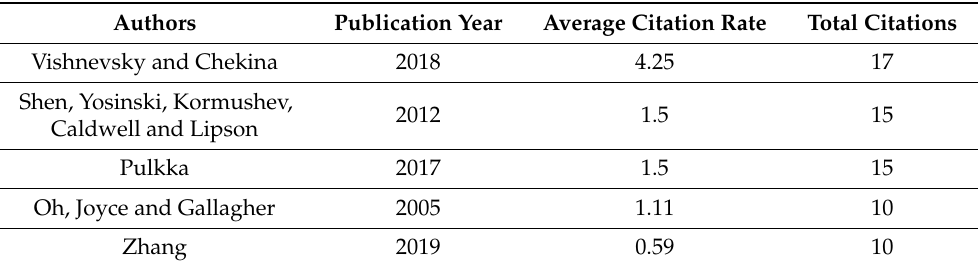
Table 3. The ranking of the most cited publications in Web of Science’ database relating to robot tax research in